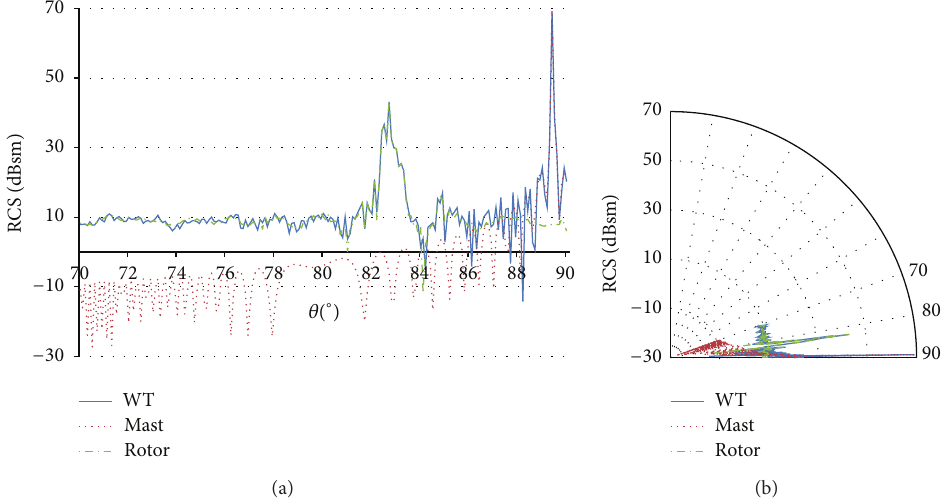
Figure 5: Wind turbine (blue line), mast (red dotted line), and rotor (green dotted line) RCS vertical pattern for the turbine model 3 at 9.945 GHz ( 𝜙 = 30 ∘ and 70 ∘ < 𝜃 < 90 ∘ ). Polar (a) and Cartesian (b) coordinate